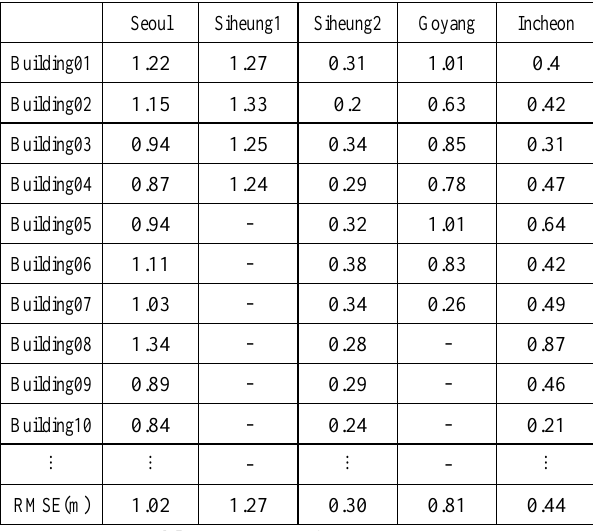
Table 2. Accuracy for each dataset